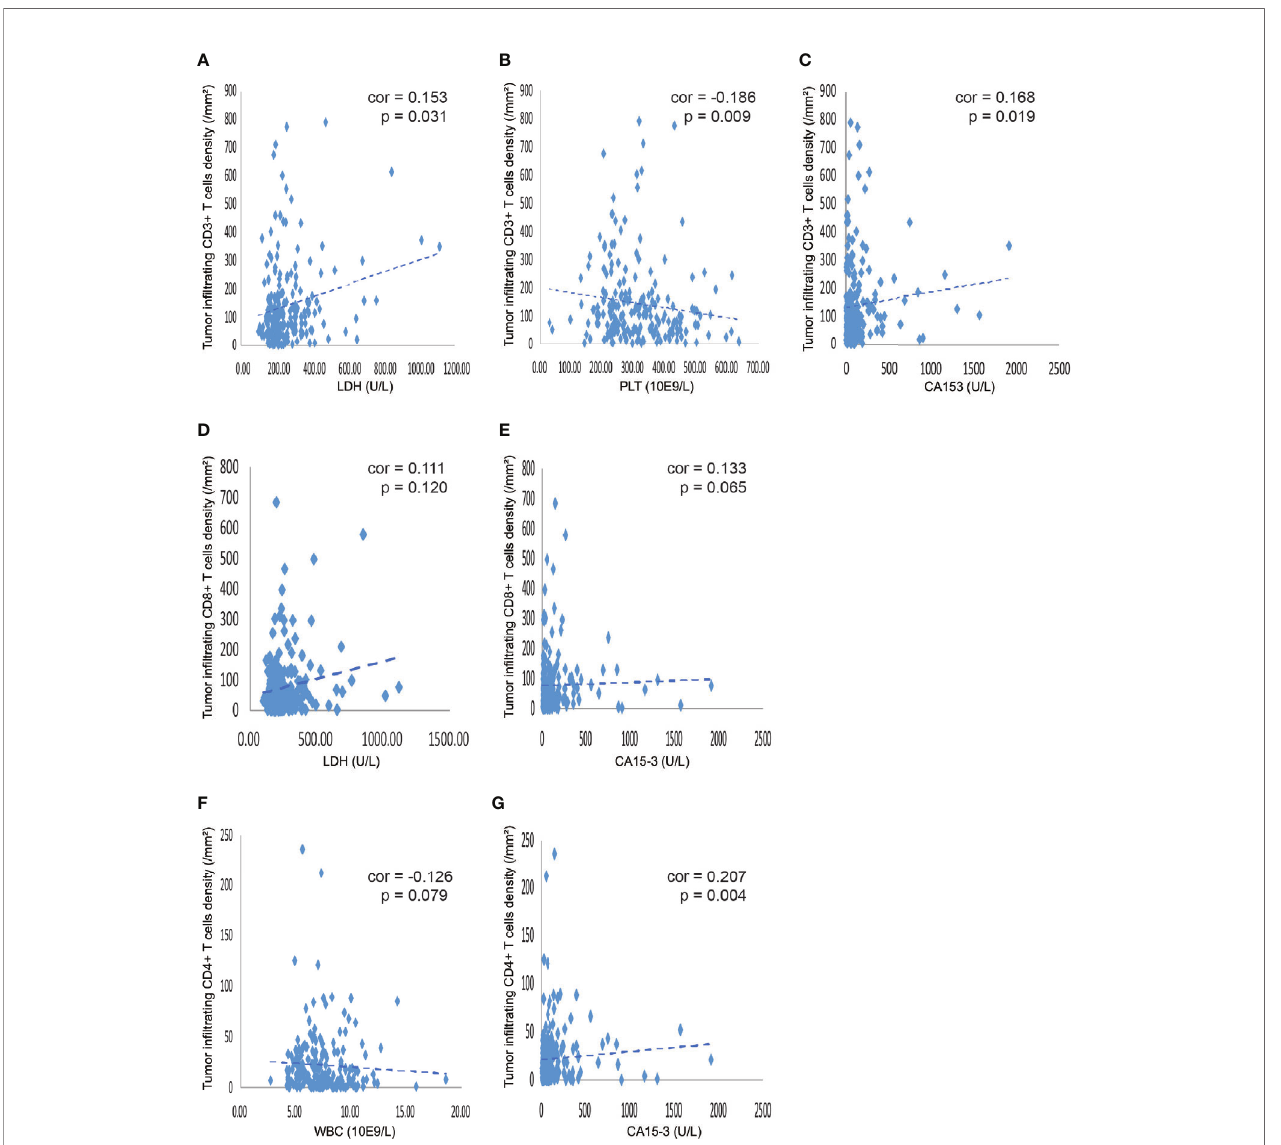
FIGURE 3 | Correlation between various blood indicators and the density of TILs. (A) The density of CD3+ TILs showed a positive correlation with the level of serum LDH, with a coef fi cient of 0.153 (p = 0.031). (B) The density of CD3+ TILs was negatively related to the PLT, with a coef fi cient of − 0.186 (P = 0.009). (C) The density of CD3+ TILs showed a positive correlation the level of serum CA153, with a coef fi cient of 0.168 (P = 0.019). (D) The density of CD8+ TILs showed a tendency that positively correlated with the level of serum LDH, with a coef fi cient of 0.111 (P = 0.120). (E) The density of CD8+ TILs showed a tendency that positively related to the serum CA153, with a coef fi cient of 0.133 (P = 0.065). (F) The density of CD4+ TILs showed a tendency that negatively correlated with the number of WBC in the blood, with a coef fi cient of -0.126 (P = 0.079). (G) The density of CD4+ TILs was positively related to the CA153, with a coef fi cient of 0.207 (P = 0.004). TILs, tumor- in fi ltrating lymphocytes; WBC, white blood cells; LDH, lactate dehydrogenase; PLT, platelet; CA153, carbohydrate antigen